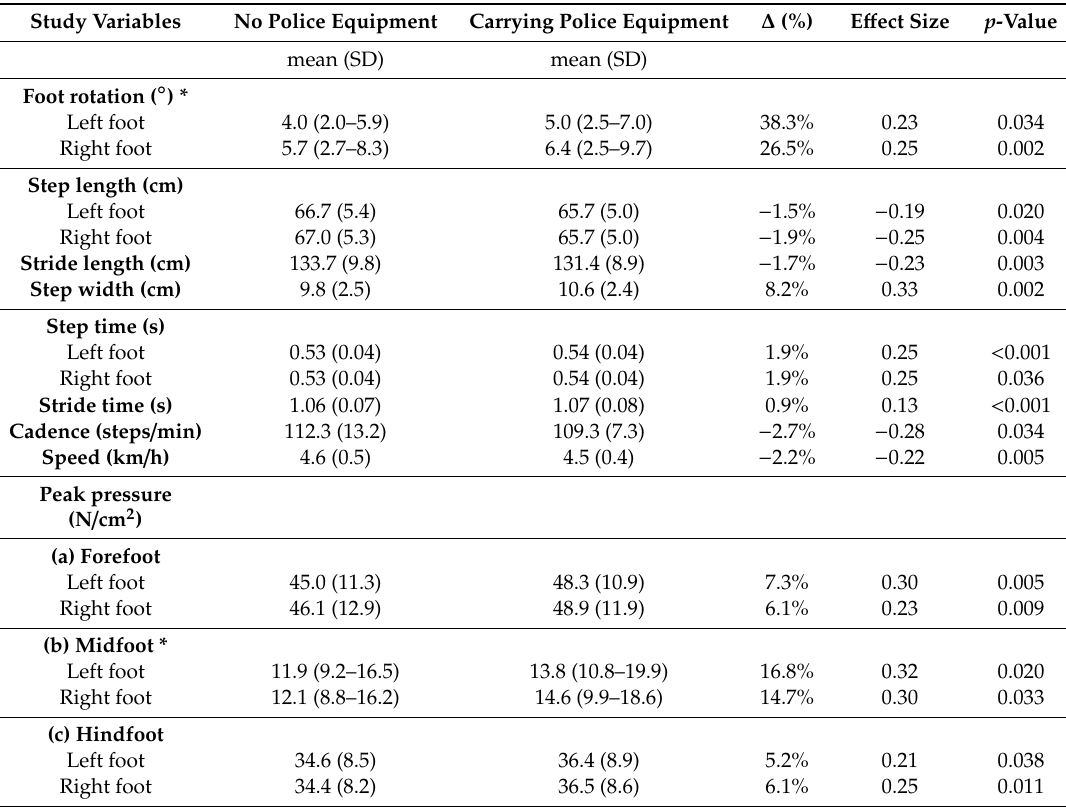
Table 3. E ff ects of carrying police equipment on spatiotemporal and kinetic gait parameters in women ( N =